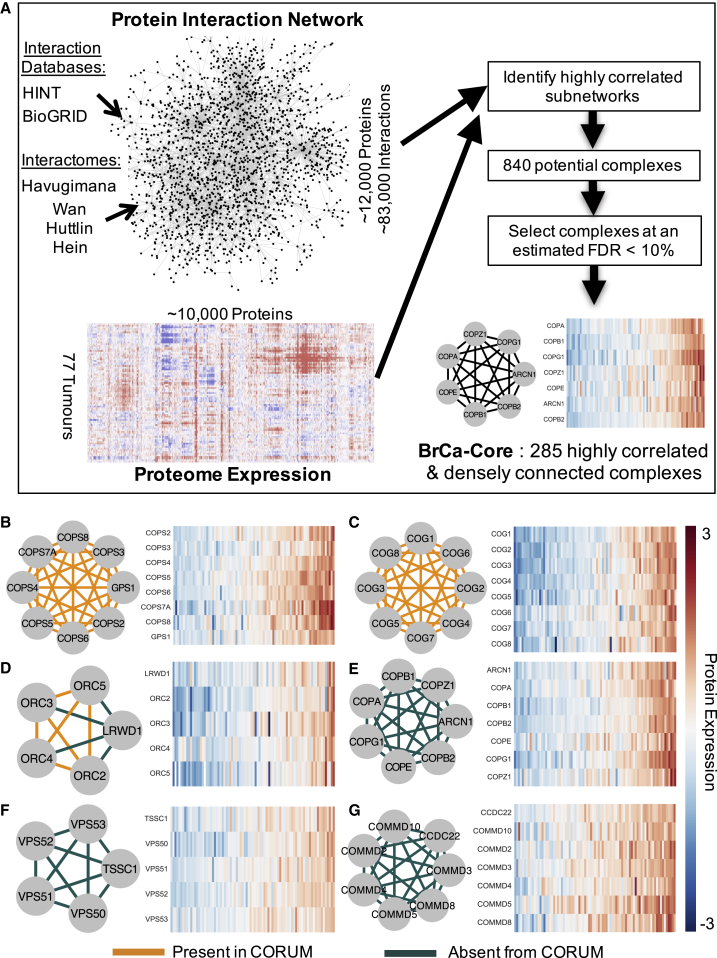
BrCa-Core Complex Discovery(A) An integrated protein-protein interaction network is combined with tumor proteomic profiles to identify sets of densely connected proteins that display correlated expression profiles across tumor proteomes. By comparing the results with those derived from randomly relabeled protein interaction networks, we can estimate the false discovery rate (FDR). The BrCa-Core set contains 285 complexes at an estimated FDR of 10%.(B) BrCa-Core 17: the COP9 signalosome. The heatmap on the right shows protein expression of all subunits across 77 breast tumor proteomes. These have been sorted based on the mean abundance of all subunits.(C) BrCa-Core 14: the conserved oligomeric Golgi (COG) complex.(D) BrCa-Core 47 contains the ORC2–5 complex found in CORUM with the addition of LRWD1.(E) BrCa-Core 25, the COPI complex.(F) BrCa-Core 48, the EARP complex with the recently identified EARP interactor TSSC1.(G) BrCa-Core 26, the Commander complex.